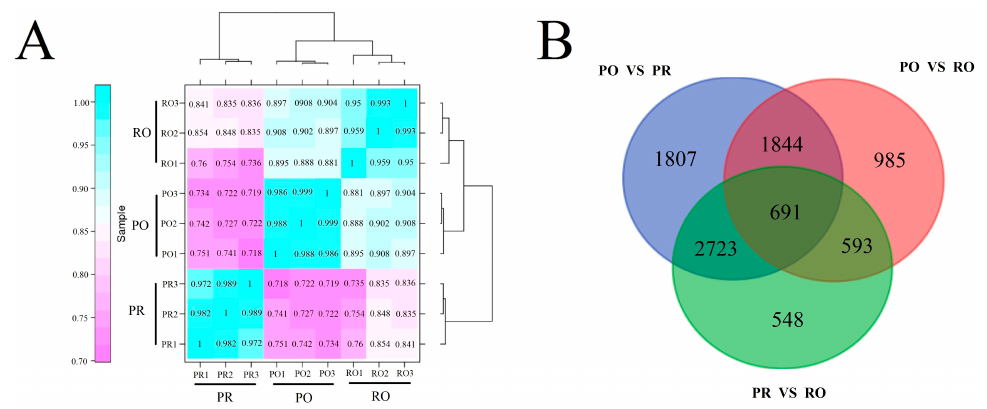
Figure 4. Gene expression profiles in three differentially colored tree peonies. ( A ) Cluster dendrogram of gene expression profiles between biological replicates and among different tree peonies. The color scale represents Pearson correlation coefficients among different samples. The higher the Pearson correlation coefficient, the closer the relationship between two libraries is. The blue represents a closer relationship, and pink represents a distant one transcriptome relationship between different samples; ( B ) Comparison in pairs of differentially expressed genes (with an FDR < 0.001 and a |log2 ratio| > 1) in different groups. The Venn diagram depicts the overlaps between each pairwise comparison. The Venn diagram was constructed online using Venny (http://bioinfogp.cnb.csic.es/tools/venny/). The expression profiles of the metabolic pathways identified in KEGG were clustered (Figure 5).